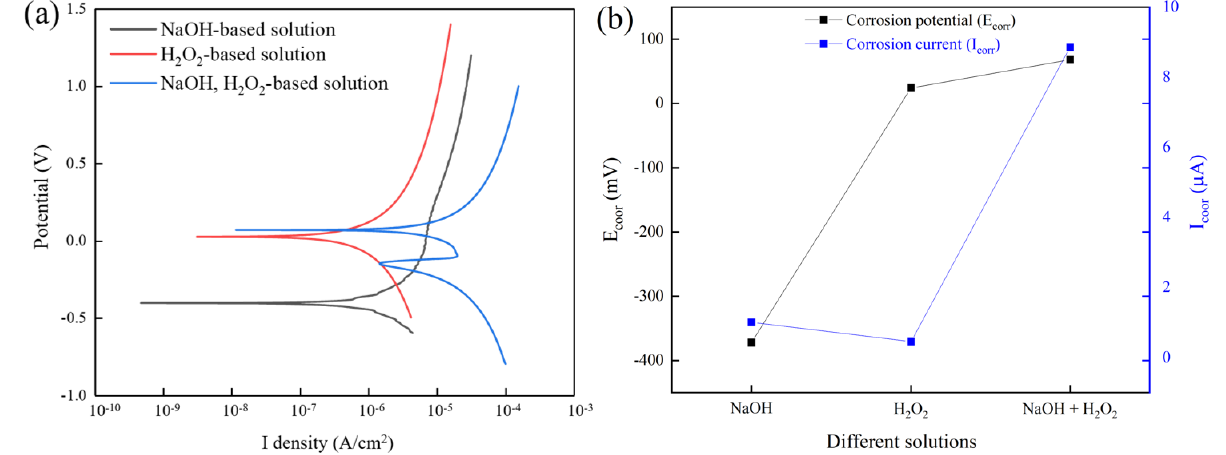
Figure 14. ( a ) Dynamic potential polarization curves at different solutions. ( b ) The corrosion potential E corr and the corrosion current density I corr at different solutions.